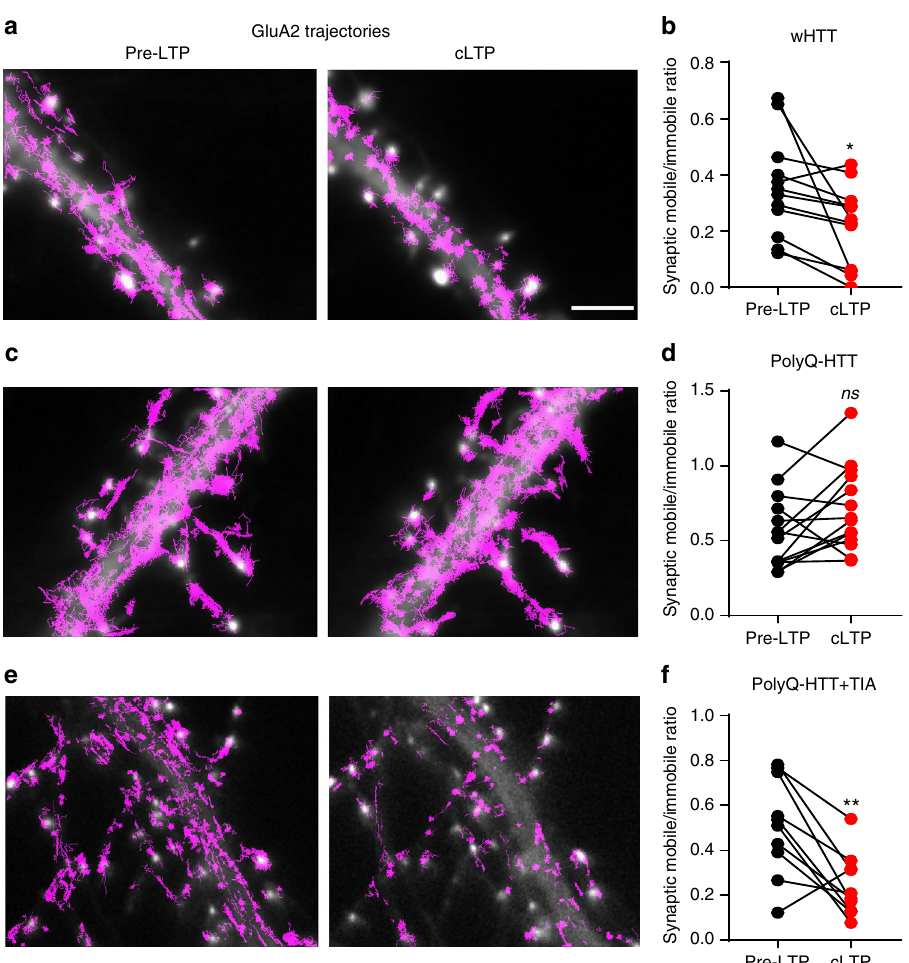
Fig. 6 AMPAR fails to stabilize on the neuronal surface after LTP stimulation, an effect rescued by tianeptine (TIA) treatment in an HD cellular model. a , c , e Typical GluA2 trajectories (magenta) before and after cLTP induction in FL-wHTT-expressing neurons without TIA treatment ( a ), FL-polyQ-HTT- expressing neurons without TIA treatment ( c ), and FL-polyQ-HTT-expressing neurons with TIA treatment (10 μ M) ( e ). Scale bar, 5 μ m. b , d , f The ratio of mobile to immobile fraction of the diffusion coef fi cient ( D ) at synapses before and after cLTP induction in FL-wHTT-expressing neurons without TIA treatment ( b ), FL-polyQ-HTT-expressing neurons without TIA treatment ( d ), and FL-polyQ-HTT-expressing neurons with TIA treatment (10 μ M) ( f ). Data were from 10 to 14 neurons from three separate experiments. Immobile fraction was identi fi ed as the proportion of receptors with D ≤ 0.01 μ m 2 s − 1 while mobile fraction with D > 0.01 μ m 2 s − 1 . Paired t test was used; * P < 0.05; ** P < 0.0;1; ns not signi fi